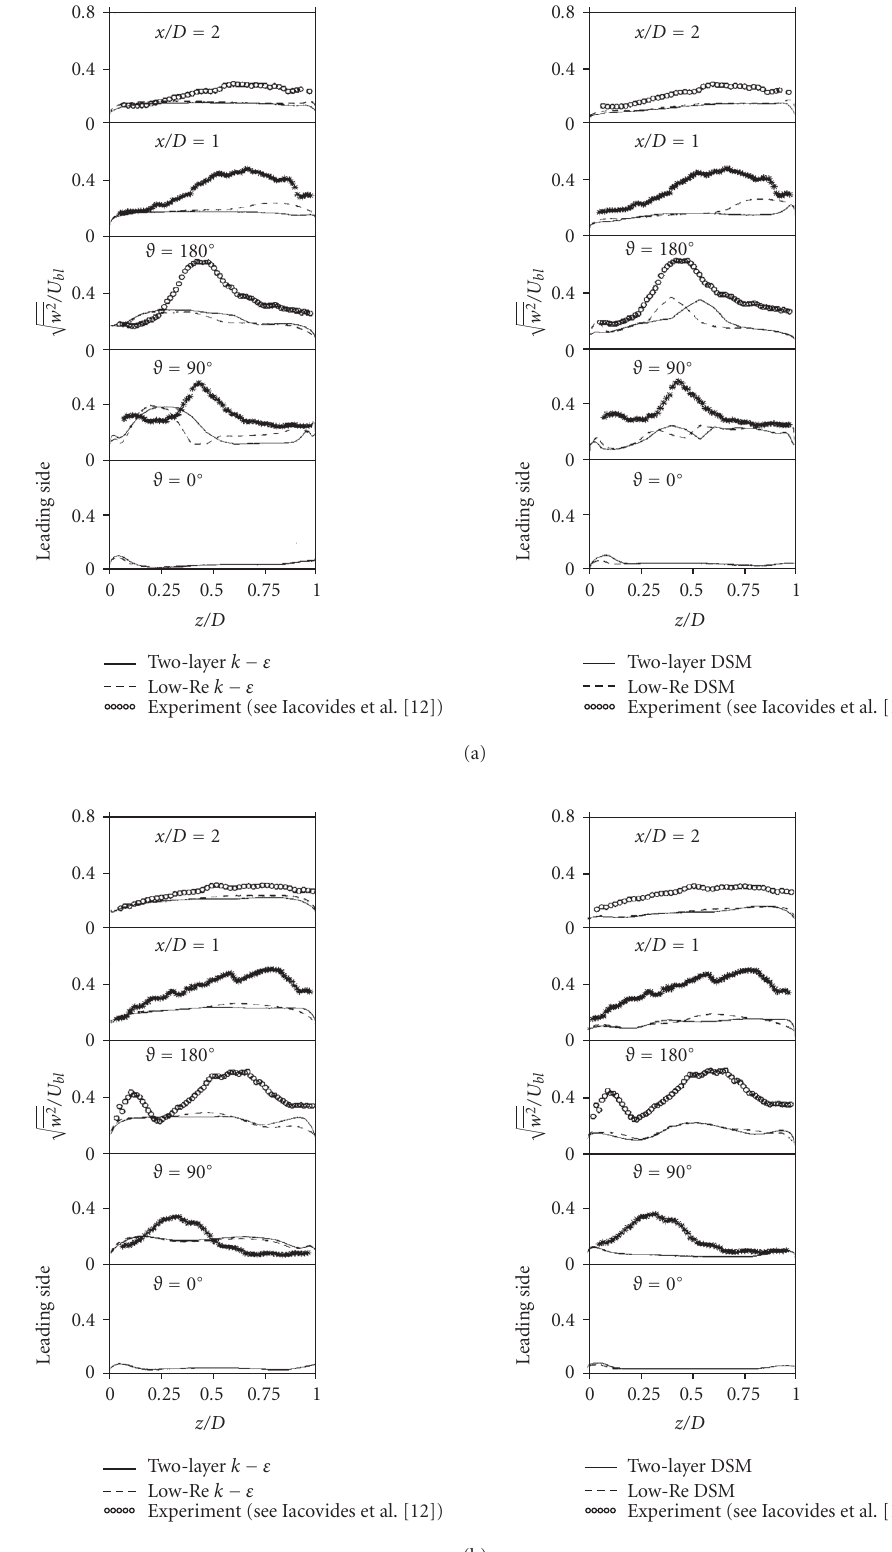
Figure 7: Comparisons between predicted and measured profiles of cross-duct turbulence intensity: (a) inner plane C and (b) mid-plane